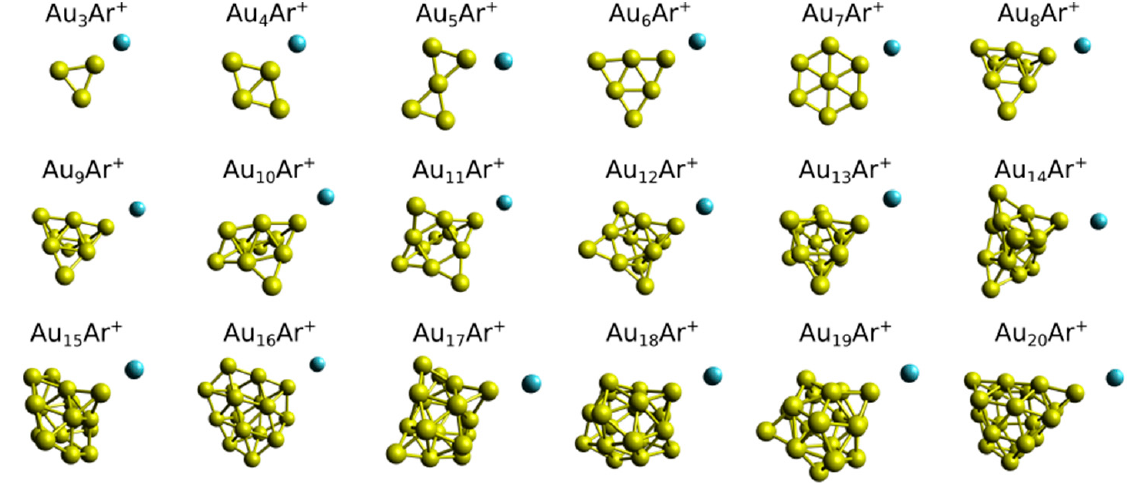
Figure 2. Optimized geometries of Au n Ar + ( n = 3–20) clusters, calculated at the PBE+D3/ECP(def2-TZVPP) level. For the single Ar lowest energy isomers up to n = 7 the Au framework is planar; for all larger sizes the metal frameworks are three-dimensional. Therefore, a first correspondence between the Au n + cluster geometries and the experimental Ar fractions is already identified, namely the amount of adsorbed Ar decreases sharply at the transition size from planar to three-dimensional clusters, i.e., after Au 7+ . A similar effect was seen in anionic Au n − species, where the size-dependent attachment of Ar was found to decrease abruptly once the clusters were three-dimensional [26]. The particular geometry adopted by the Au 15+ cluster may also provide a hint for the higher F 15 (1) fraction. It is formed by a double layer of atoms, with a Au atom located on one layer [38]. As shown in Figure 2,